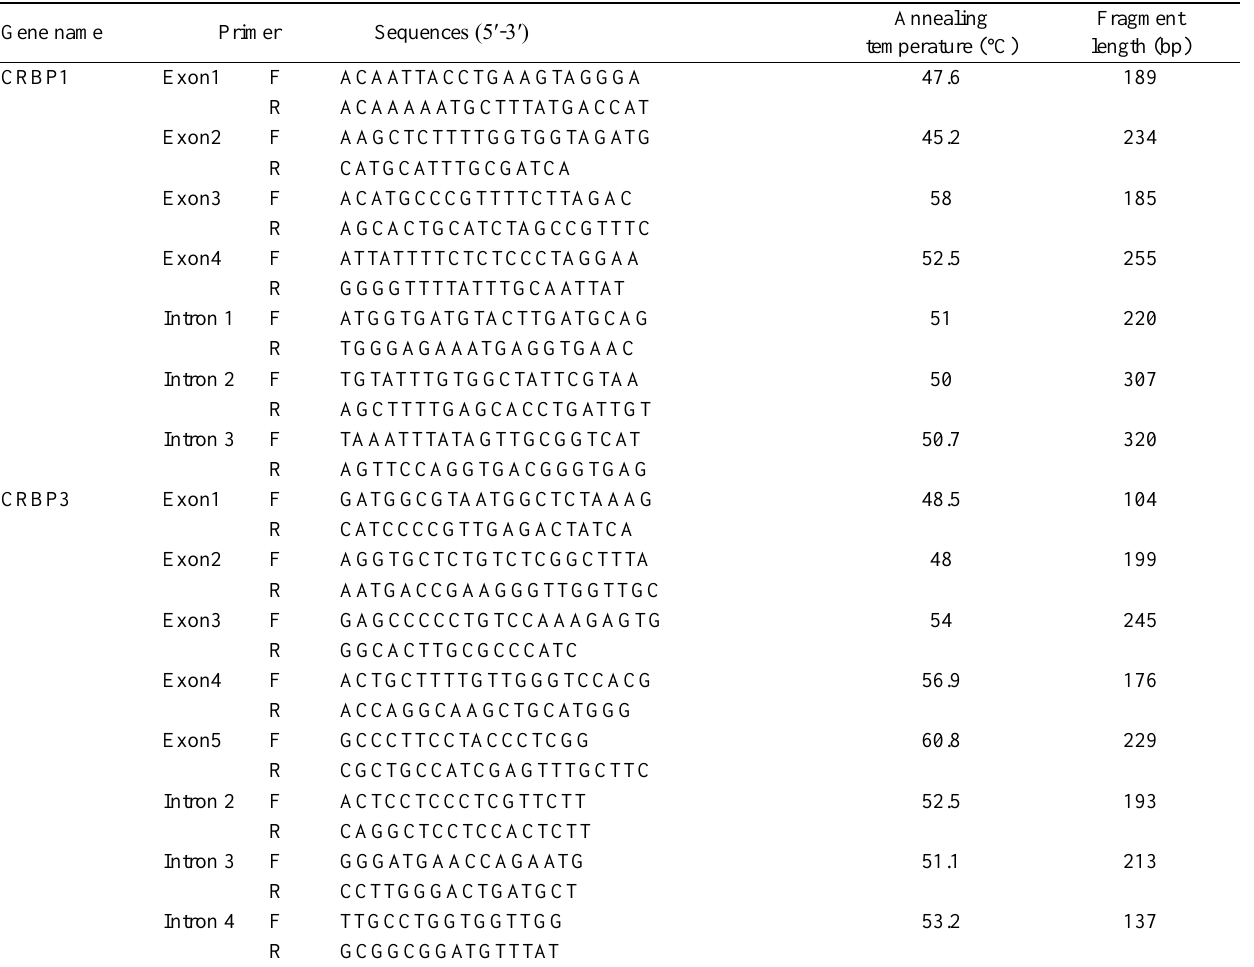
Table 1. Detailed information of the primers used for the single nucleotide polymorphism scanning of CRBP1 gene and CRBP3 gene Gene